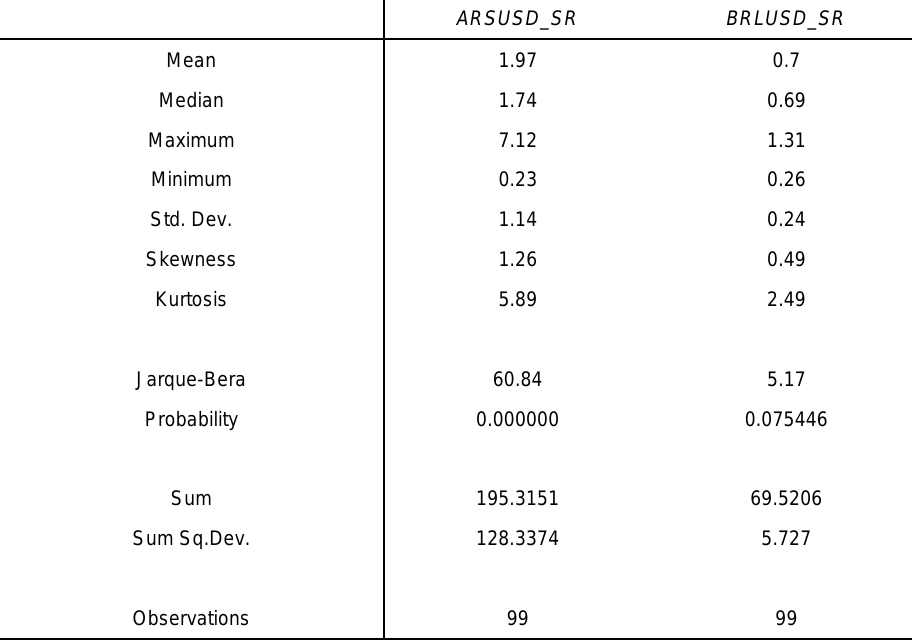
Table 1. Descriptive statistics for the ex-ante Sharpe Ratio series (January 2007 to March